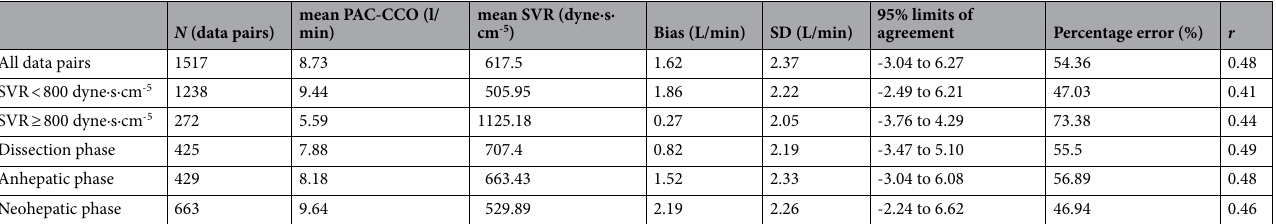
Table 2. Results of Bland–Altman analysis and Pearson correlation analysis.